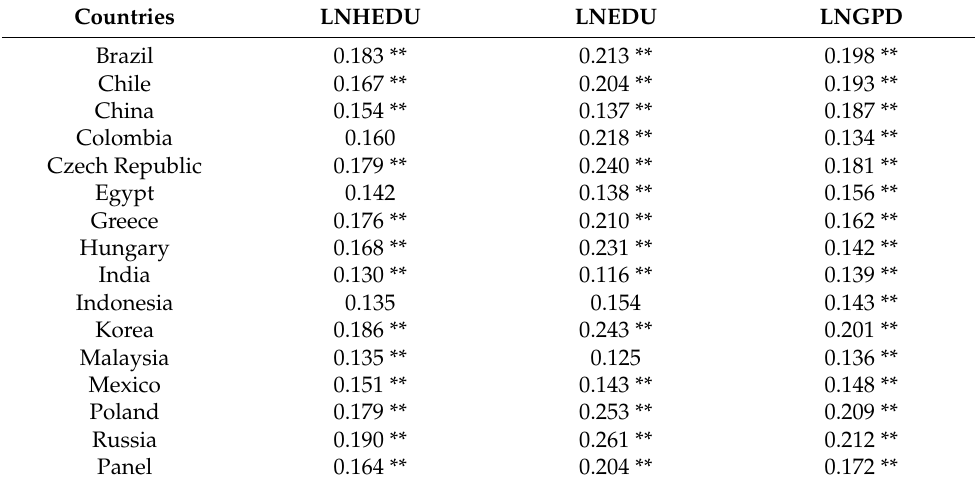
Table 8. Estimation results of cointegration